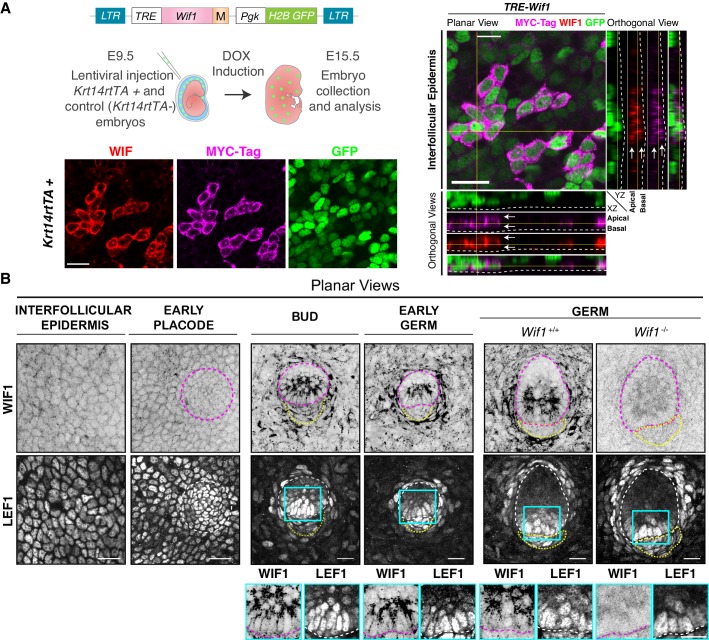
WIF1 expression during early hair follicle development.(A) Strategy to monitor WIF1 expression by MYC-tagging (M). Depicted LV was introduced into the amniotic cavities of E9.5 Krt14rtTA embryos, and transduced genes were activated by doxycycline (DOX). Representative whole-mount and orthogonal views of WIF1-MYC-tag and WIF1 immunostaining of E15.5 embryos. Note uniform distribution of protein within the plane of the embryonic epidermis (white arrows). Dashed line demarcates the border between epidermis and dermis. Yellow lines represent the corresponding orthogonal views. Scale bar, 20 μm. (B) Endogenous WIF1 localization is shown by whole-mount immunofluorescence of interfollicular epidermis, hair placodes, hair buds and hair germs. Note that WIF1 is increased in the hair bud and germ epidermis but is only expressed at the bud stage in the early dermal condensate (yellow dotted lines). Note also the distinct apical localization of WIF1 in hair buds and germs. Wif1 full KO embryos were used to test the specificity of the antibody, shown here for the hair germ stage. Boxed areas in blue are magnified below each image, with WIF1 and LEF1 immunolabels. Scale bars, 20 μm.